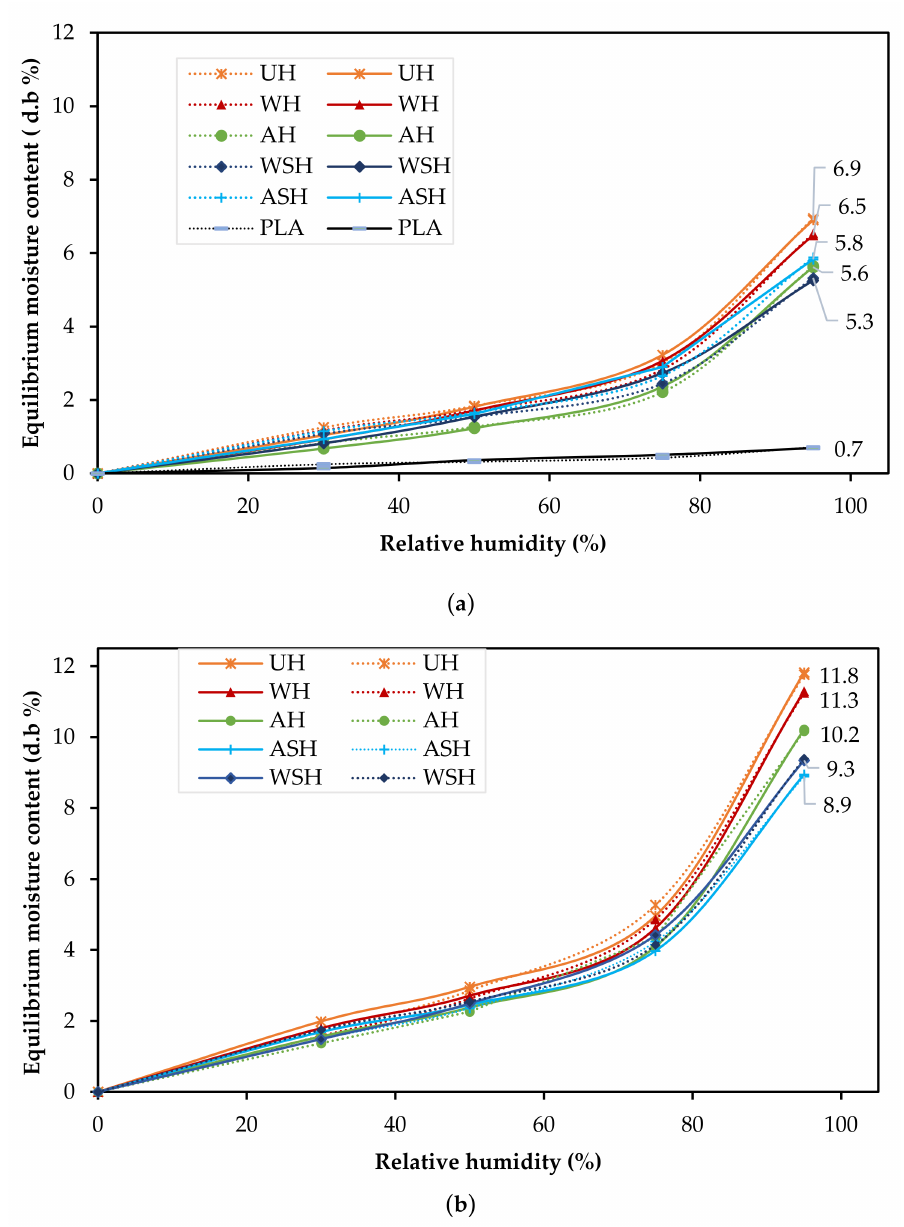
Figure 6. Adsorption isotherms (predicted (- -) and observed (—) for ( a ) the neat PLA, the 30wt.% composites and ( b ) the 50 wt.% composites (untreated (UH ж ), water pretreated (WH (cid:78) ), alkali pretreated (AH • ) and combined treatment with silane (water (WSH (cid:7) ); alkali (ASH +